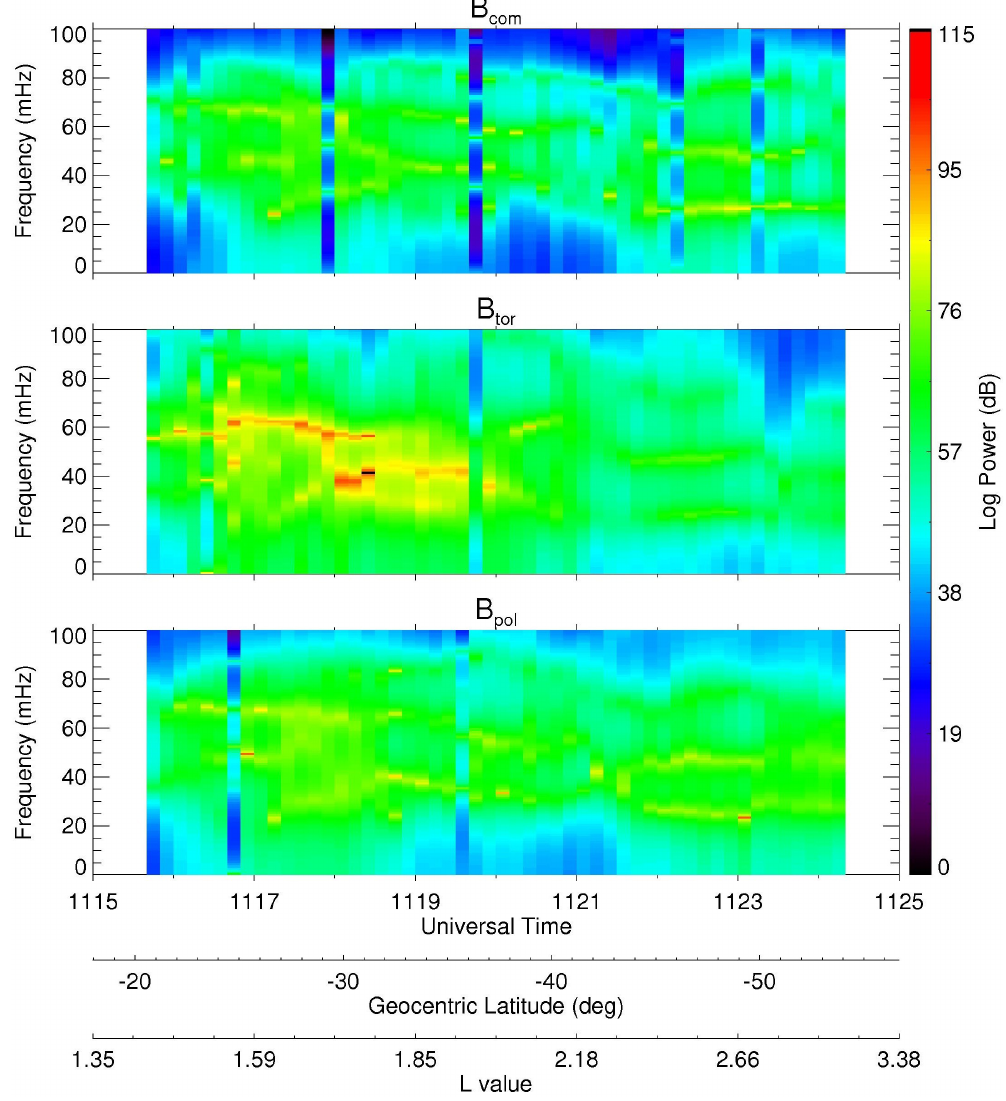
Fig. 5b. MESA dynamic spectra for magnetic field components as measured by the CHAMP satellite on 15 February 2003. Also shown are the geocentric latitude and L-shell values during the satellite